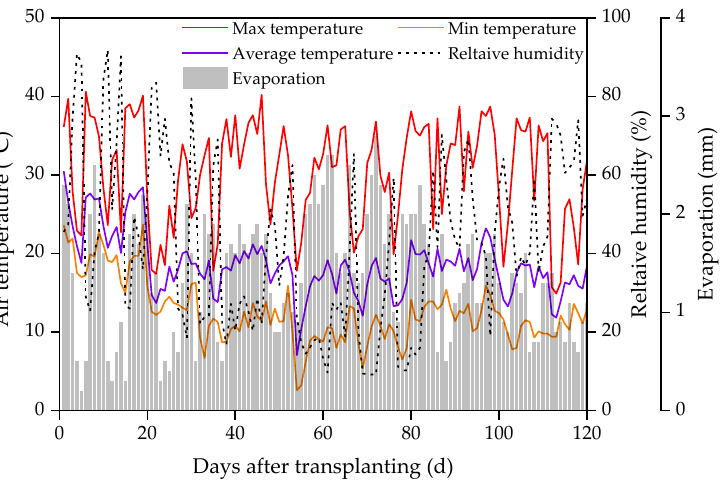
Figure 1 . Daily evaporation, daily air temperature (including daily maximum, minimum, and aver- age), and daily relative humidity (RH) during the growing season of greenhouse